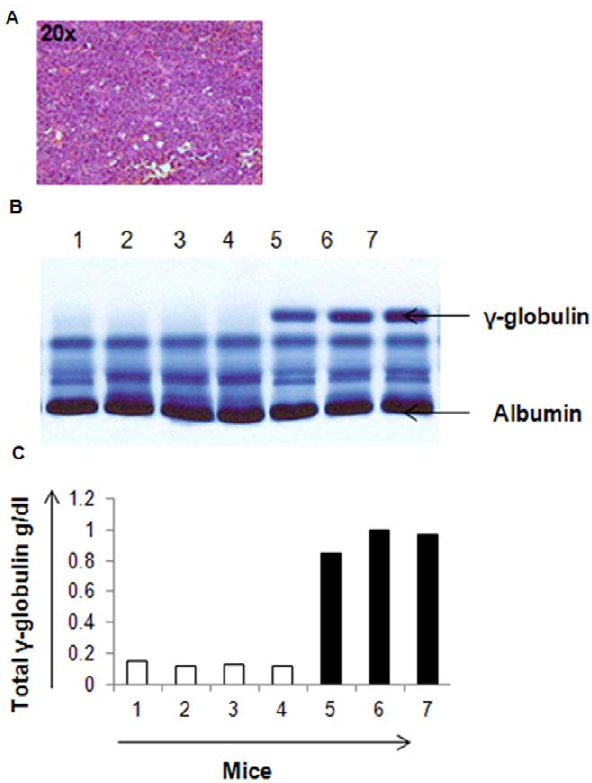
Figure 7. Tumor histology and SPEP (Serum Protein Electro- phoresis) analysis on the serum of KaLwRij mice. A. Hematoxylin and eosin (H&E) stained slide of a representative 5TGM1 s.c. tumor tissue. The tumor cells show irregularly shaped nuclei and increased mitosis consistent with myeloma pathogenic features. B. SPEP gel showing qualitatively the c -globulin (M protein) in tumor bearing (lanes 5, 6 & 7) and non-tumor bearing (lanes 1, 2, 3 & 4) mice. The 5TGM1 tumor bearing mice (lanes 5, 6 & 7) were analyzed two weeks post tumor cell inoculation. The top arrow represents the M Protein band and the lanes represent serum SPEP for each mouse. C) Quantitative representation of the total c -globulin g/dl in the mice (1–7).